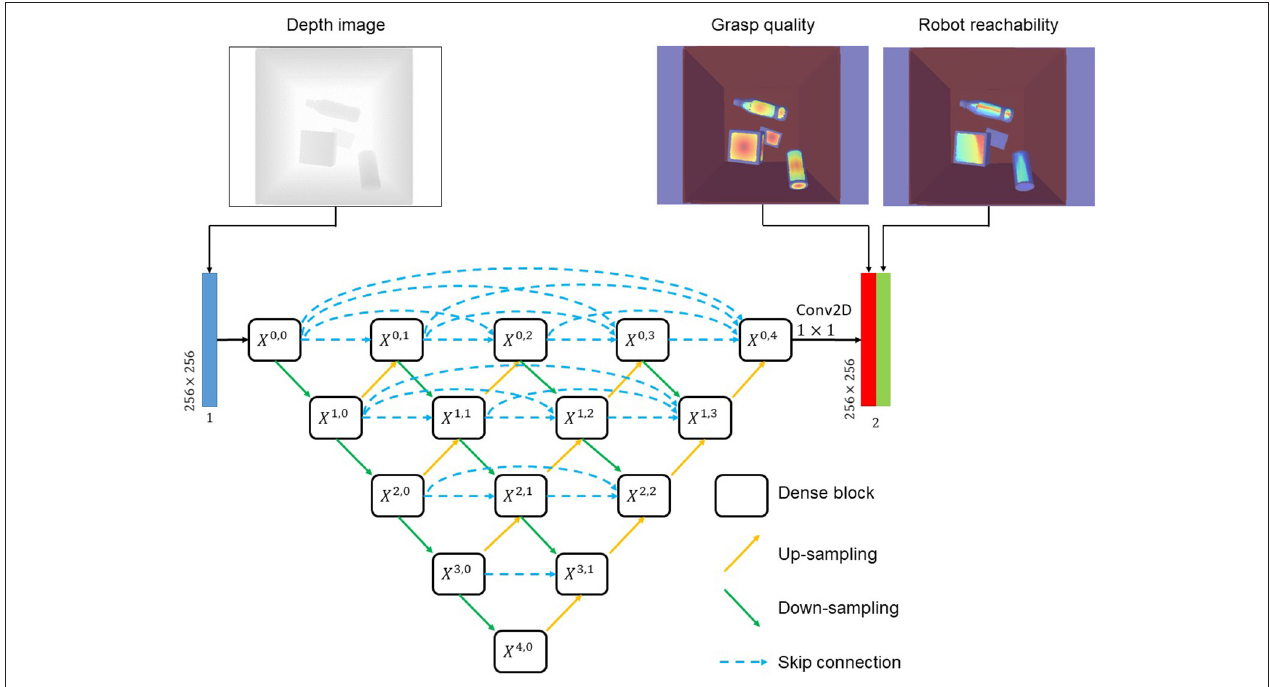
FIGURE 4 | The architecture of SG-U-Net ++